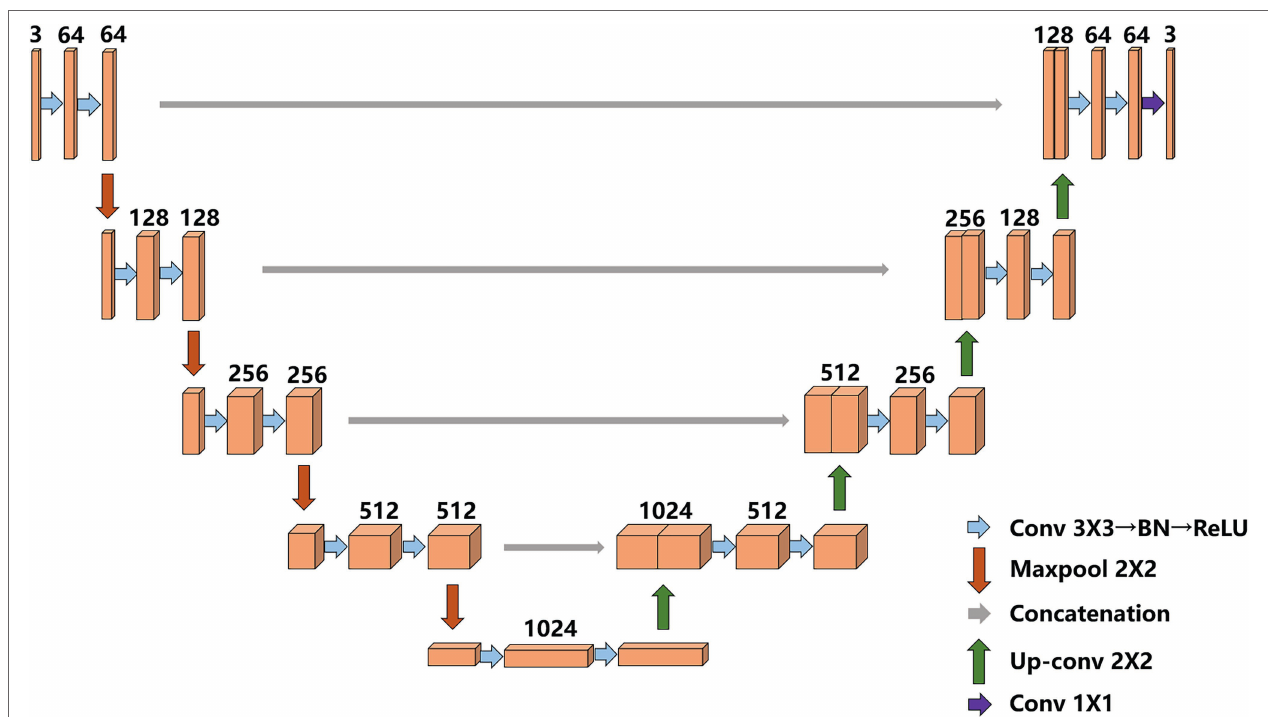
FIGURE 3 | Original UNet model